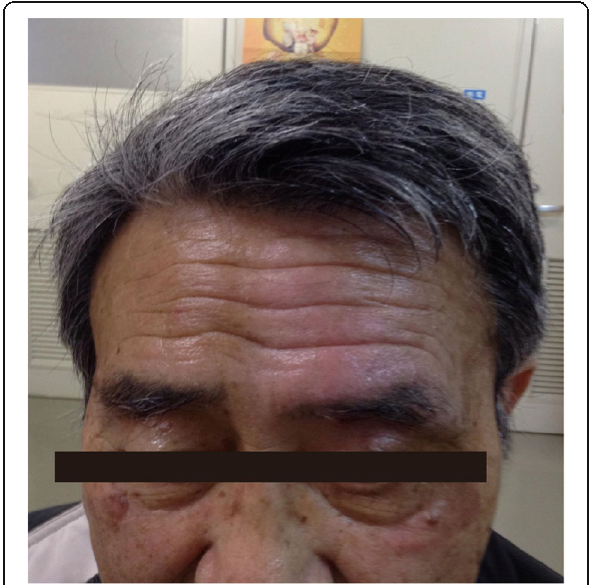
Fig. 1 Photograph of the patient taken at 1 week after the supraorbital nerve block using 4% tetracaine dissolved with 0.5% bupivacaine. Mild edema around his left eyelids was